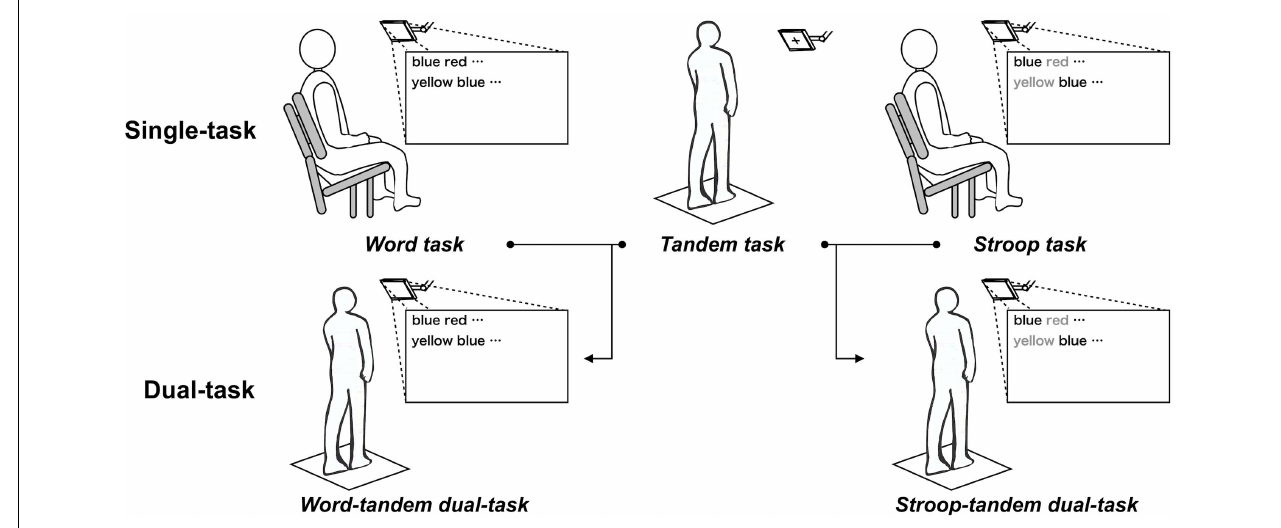
FIGURE 1 | Construction of the word-tandem task. Single-tasks consisted of the word, Stroop, or tandem task. Dual-tasks were constructed from the word task and tandem task (word-tandem dual-task) or from the Stroop task and tandem task (Stroop-tandem